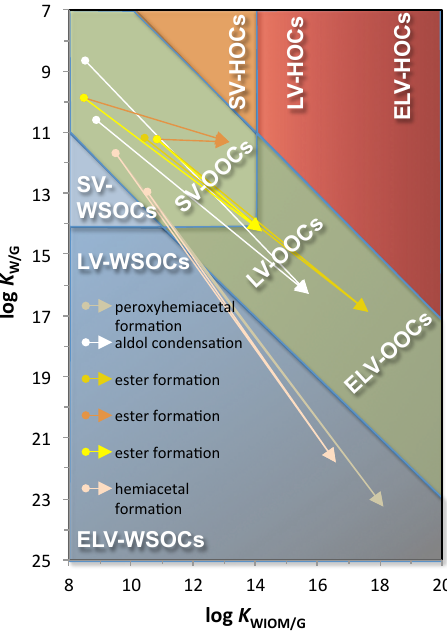
Figure 11. Visualisation in the partitioning space of processes oc- curring during the oxidation of VOC precursors in a chamber exper- iment or a photochemical smog episode (in the presence of water). While the addition of functional groups and dimerisation reactions lead to an increase in K WIOM / G and K W / G and therefore a gradual shift to the lower right, the attendant increase in the organic aerosol load shifts the threshold for the gas–WIOM transition to the